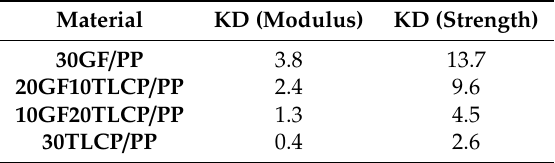
Table 2. The knock down (KD) factor of the in situ hybrid